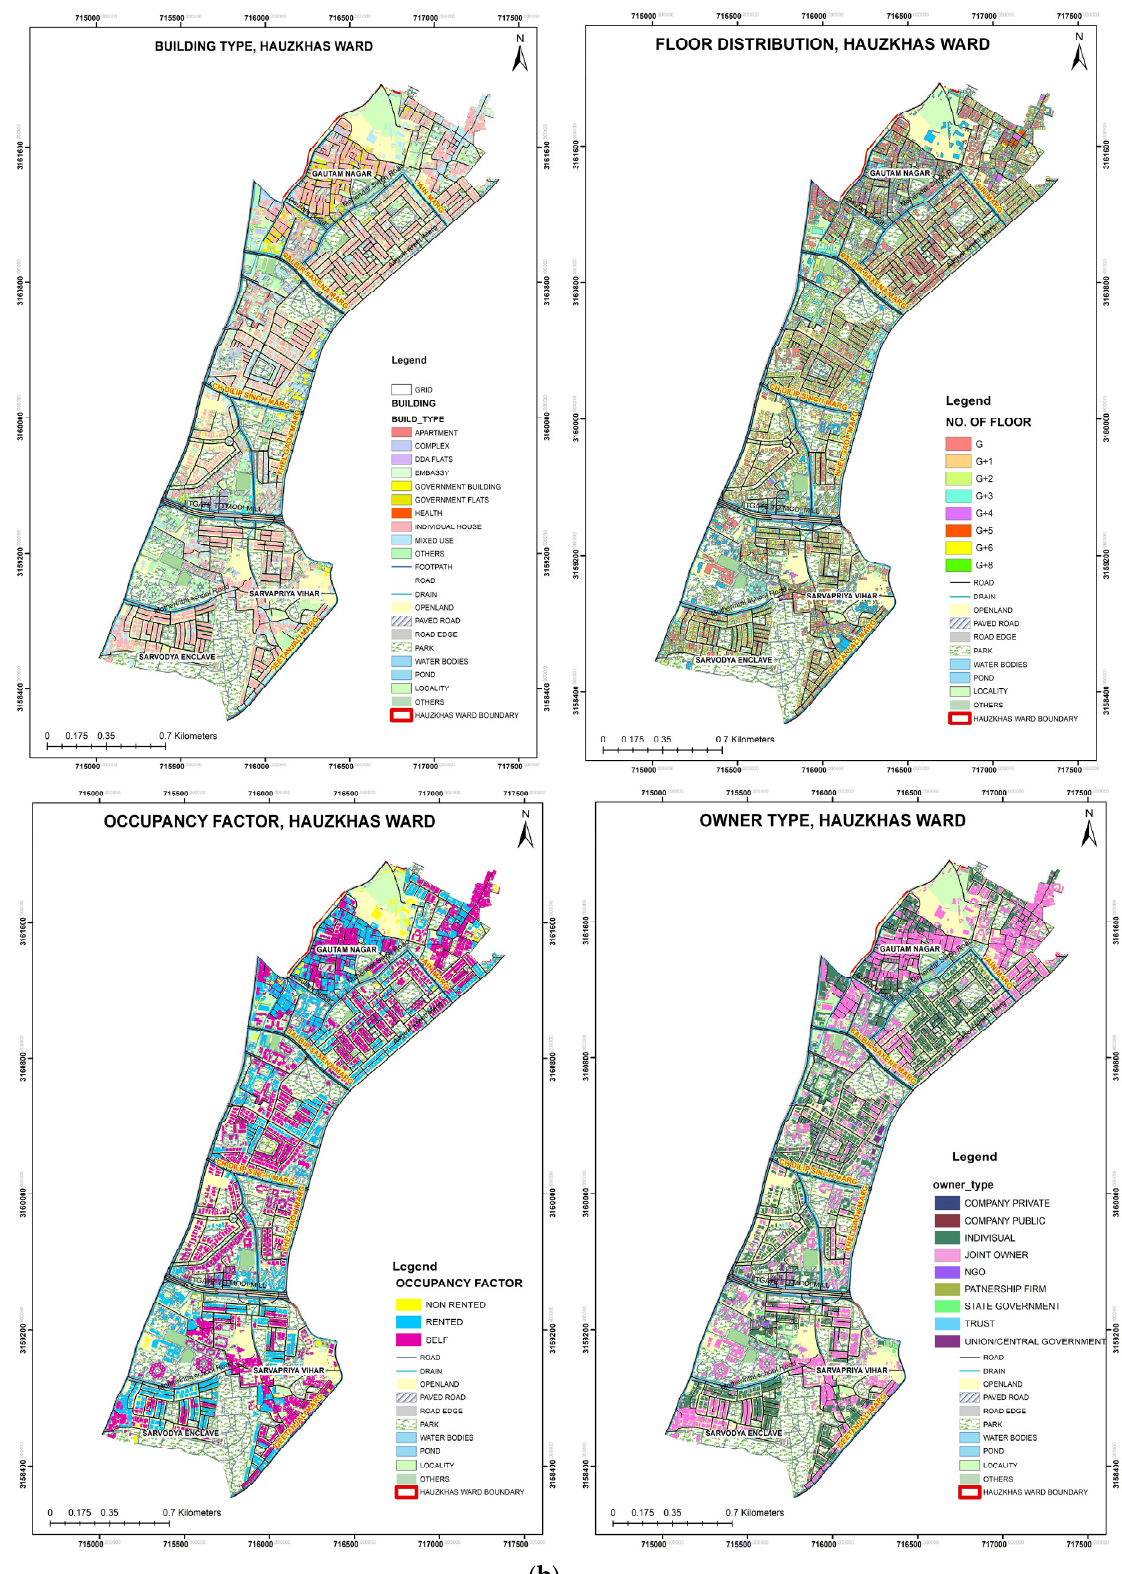
Figure 7. Information required for calculating the annual tax i.e., structure type, building type, floor distribution, and owner type. ( a ) Zoomed-in view ( b ) Overall Hauz Khas